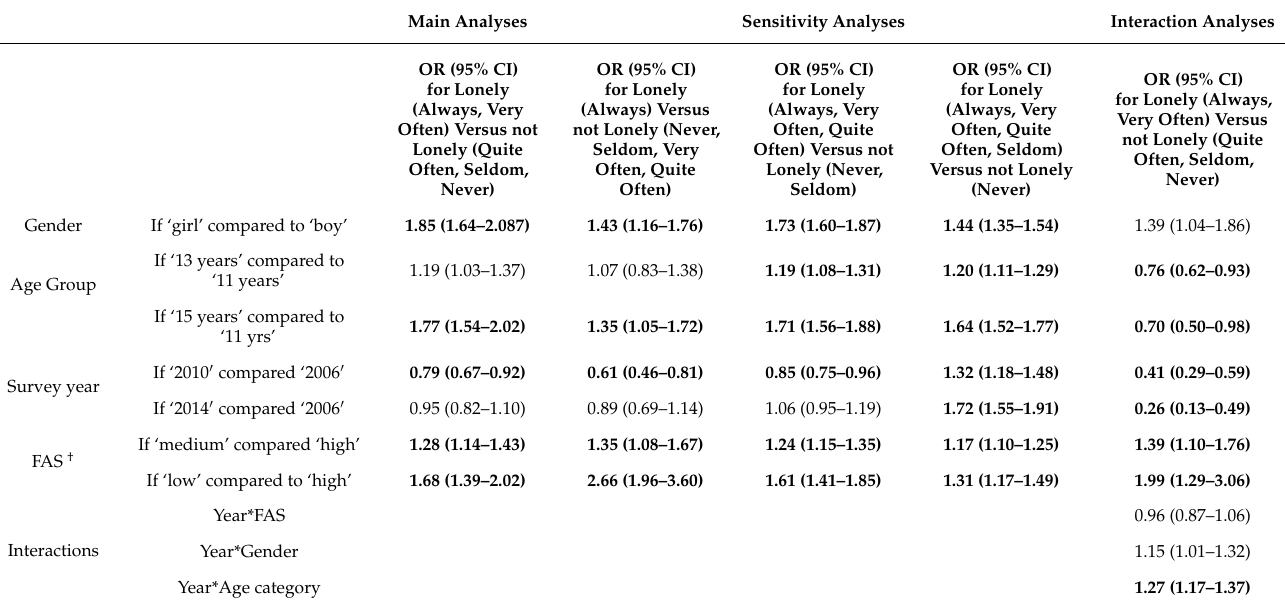
Table 2. MLM logistic regression—Predictors of